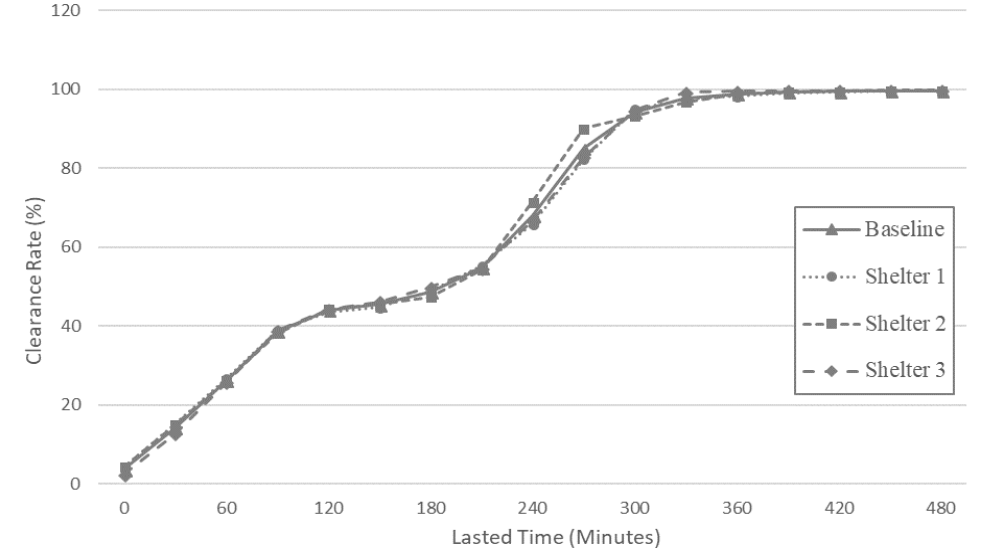
Figure 8. Clearance rate of the baseline scenario.